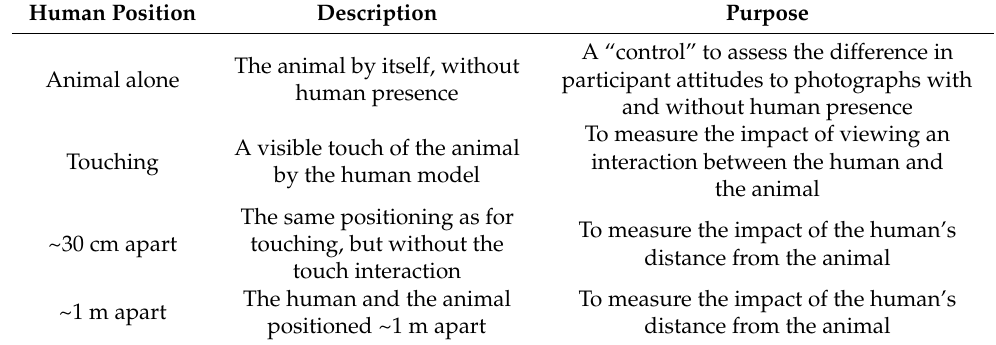
Table 1. Different Human Positions and the purpose of their inclusion in the study. Human Position Description Purpose A “control” to assess the difference in The animal by itself, without participant attitudes to photographs with Animal alone human presence and without human presence To measure the impact of viewing an A visible touch of the animal interaction between the human and Touching by the human model the animal The same positioning as for To measure the impact of the human’s ~30 cm apart touching, but without the distance from the animal touch interaction The human and the animal To measure the impact of the human’s ~1 m apart positioned ~1 m apart distance from the